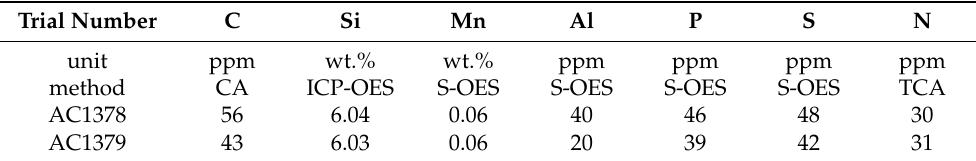
Table 1. Chemical composition of the cast trials AC1378 and